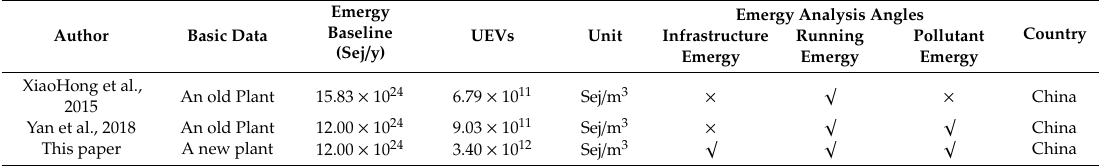
Table 12. Comparison of existing articles on unit emergy values (UEVs) in